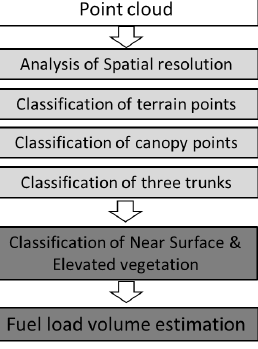
Figure 3: Detailed workflow